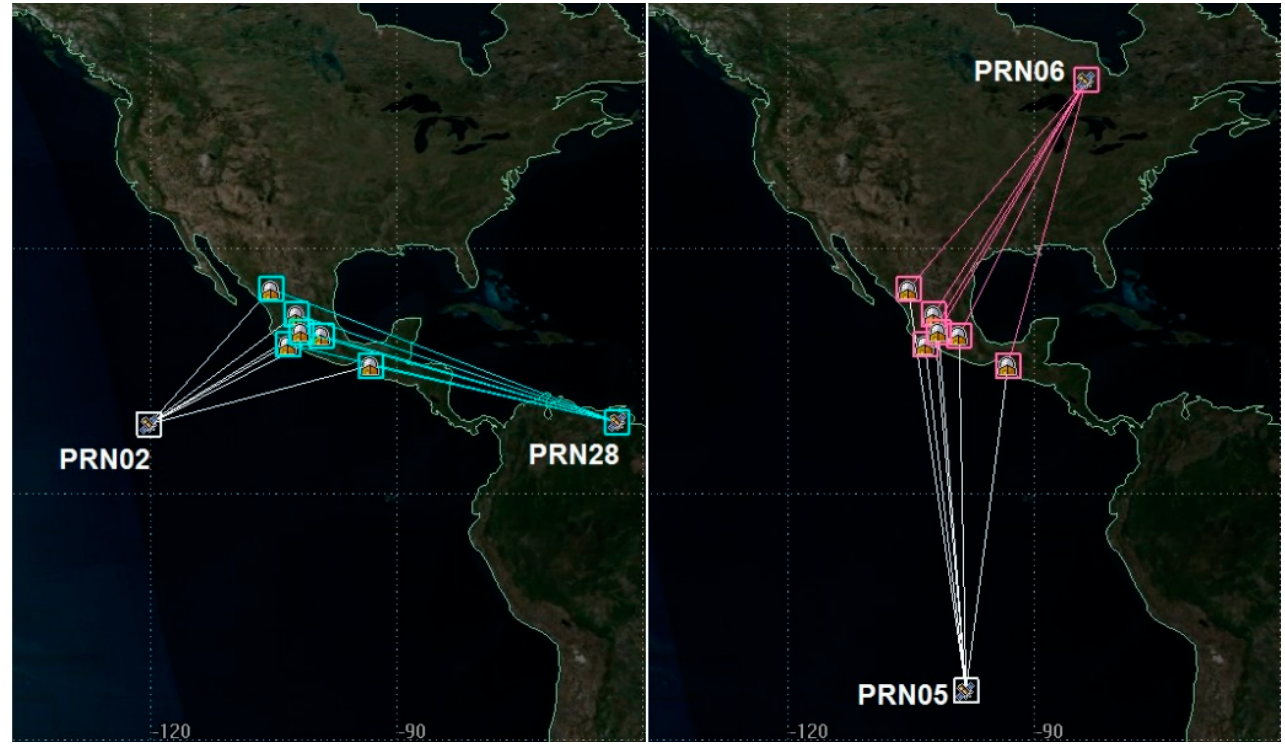
Figure 15. Schematic illustration of the geometry of LoSs to PRN02 and PRN28 ( left ) and PRN05 and PRN06 ( right ).